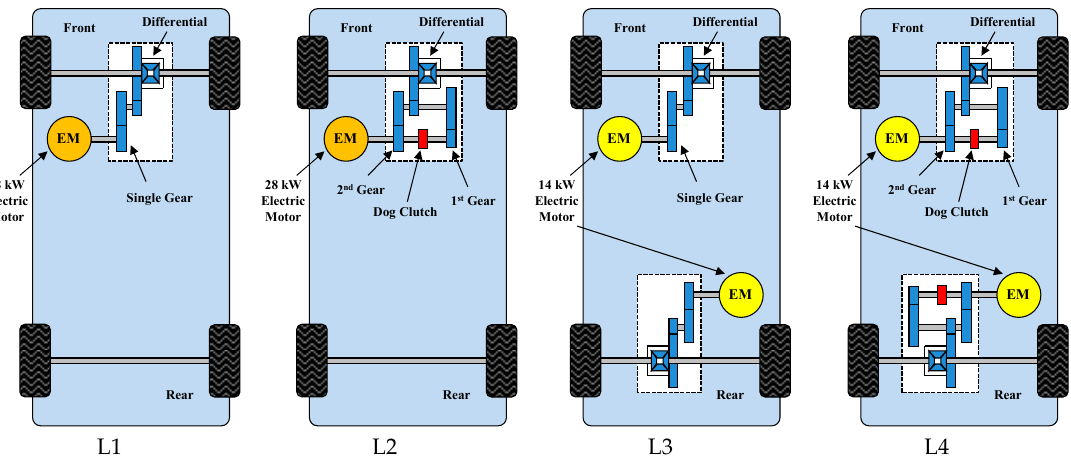
Figure 2. The considered EV layouts, with one (L1 and L2) or two (L3 and L4) electric motors, coupled with single-speed (L1 and L3) or 2-speed (L2 and L4) transmissions.